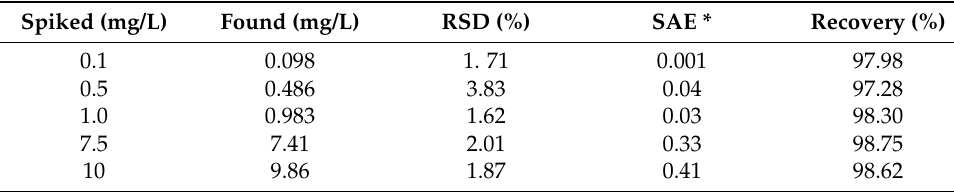
Table 4. Recovery studies for the determination of